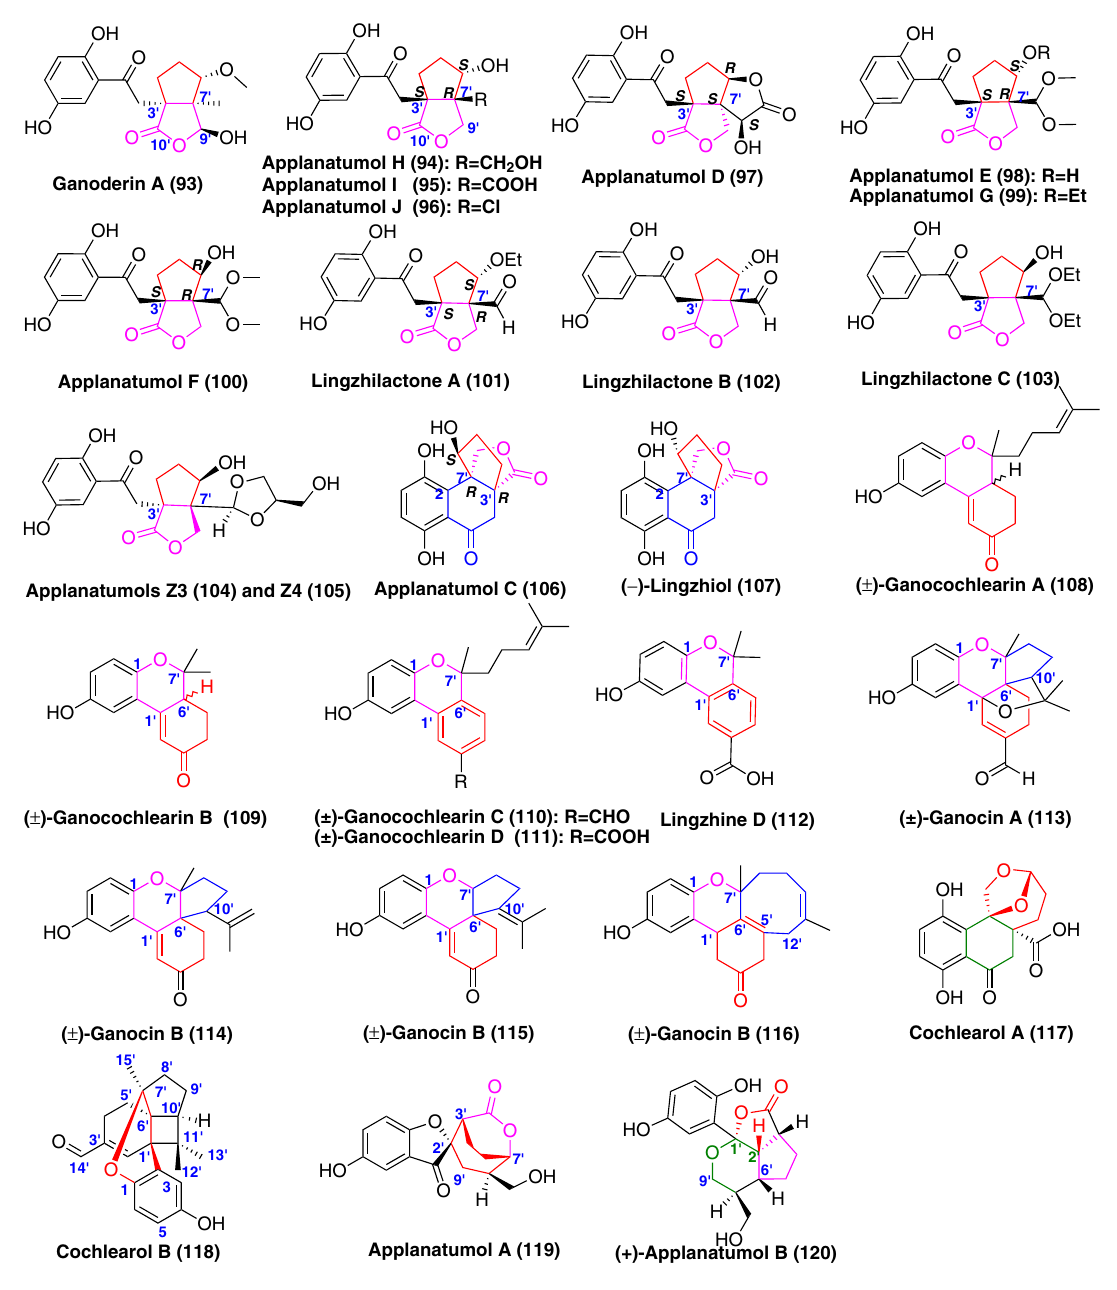
Fig. 7 Structures of GMs with bridge